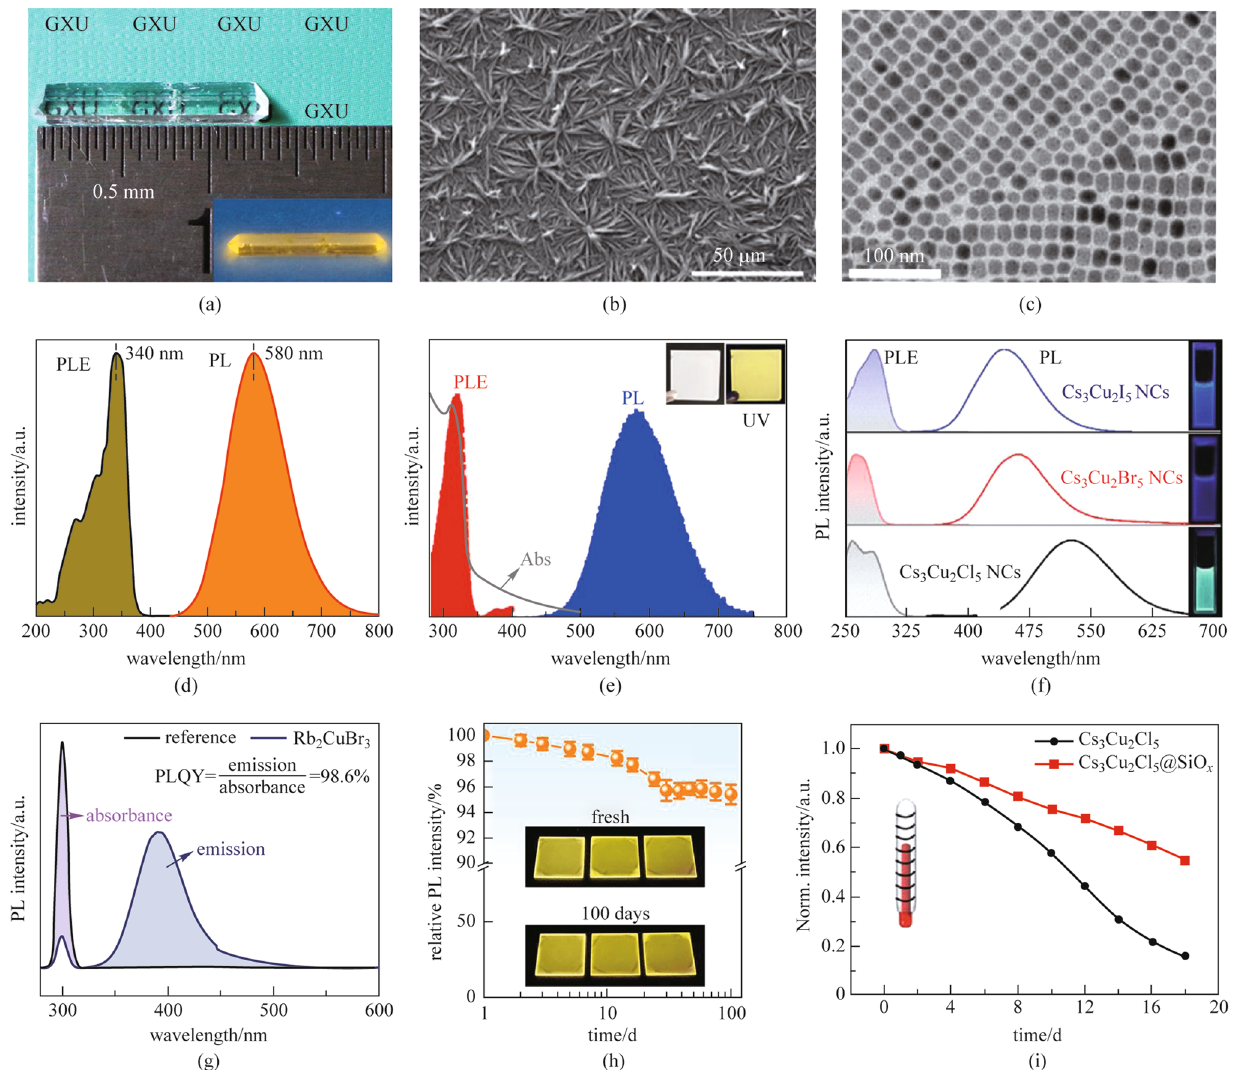
Fig. 2 a Photographs of CsCu 2 I 3 single crystals under ambient light and 365 nm UV light (inset). Reprinted with permission from Ref. [44], Copyright 2021, ELSEVIER; b SEM image of CsCu 2 I 3 film. Reprinted with permission from Ref. [46], Copyright 2020, American Chemi- cal Society; c TEM image of Cs 3 Cu 2 I 5 nanocrystal. Reprinted with permission from Ref. [52], Copyright 2020, WILEY–VCH Verlag